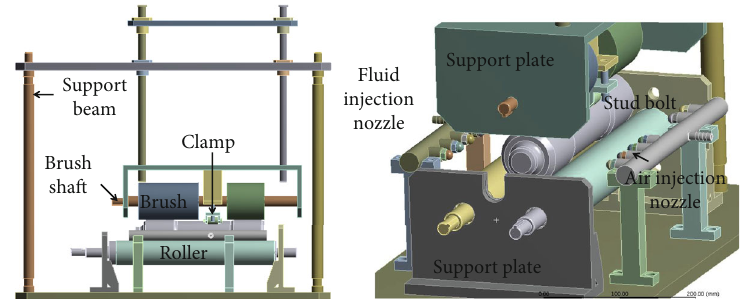
Figure 11: 3D modelling for structural analysis.